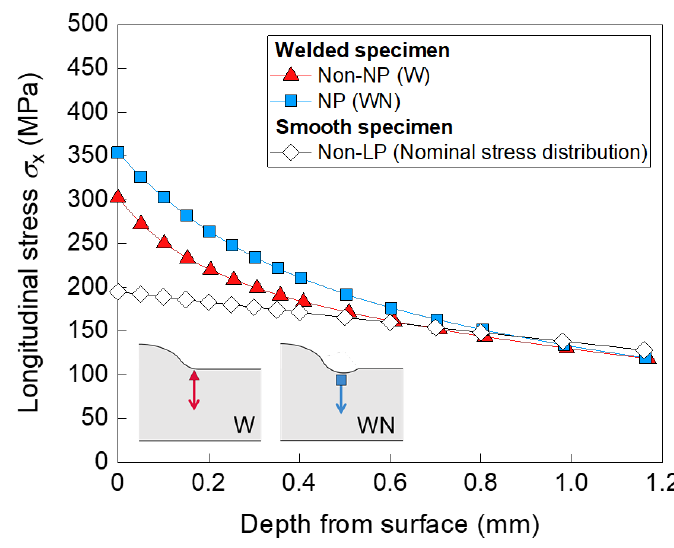
Figure 13. Distribution of the longitudinal stress at the weld toe.